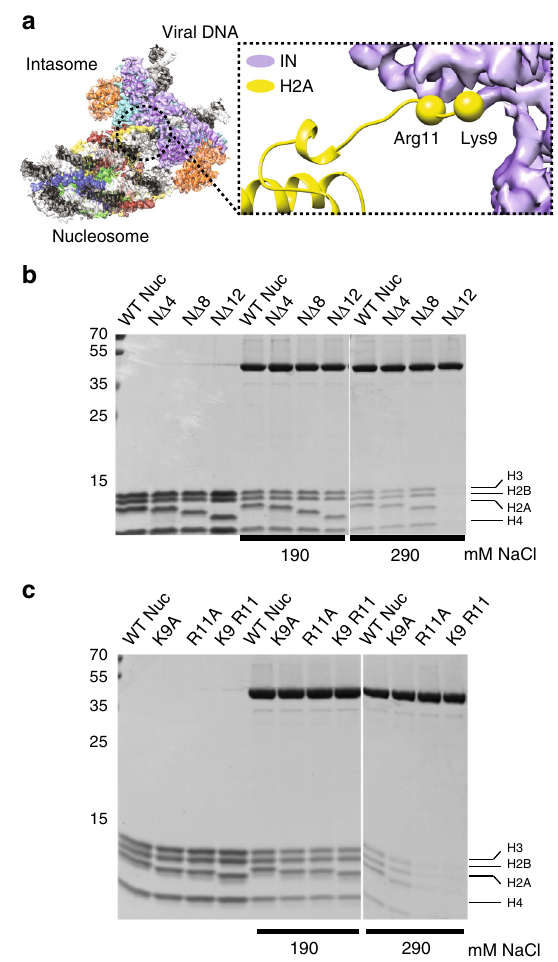
Fig. 2 Intasome interaction with the N-terminal histone H2A tail. a Histone H2A residues Lys-9 and Arg-11 play a role in the intasome-NCP interaction. b , c Pull-down with immobilised intasome binding to NCP bearing deletions b or amino acid substitutions c in the H2A N-terminal tail. N Δ 4, N Δ 8, N Δ 12, NCP variants lacking the fi rst 4, 8 or 12 residues fo histone